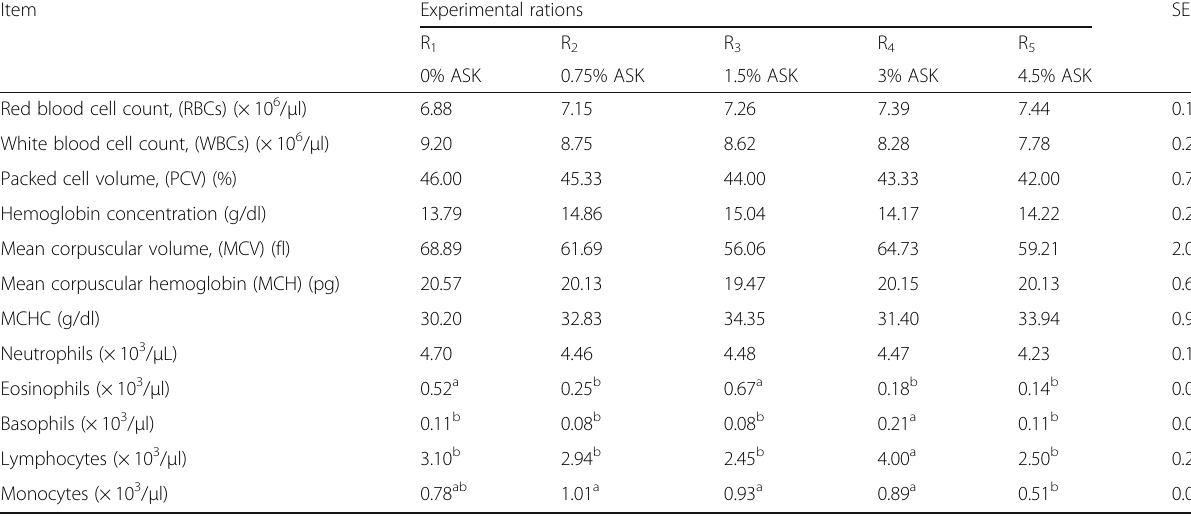
Table 5 Hemogram of the experimental groups of rabbits received ASK for 72 days Item Experimental rations